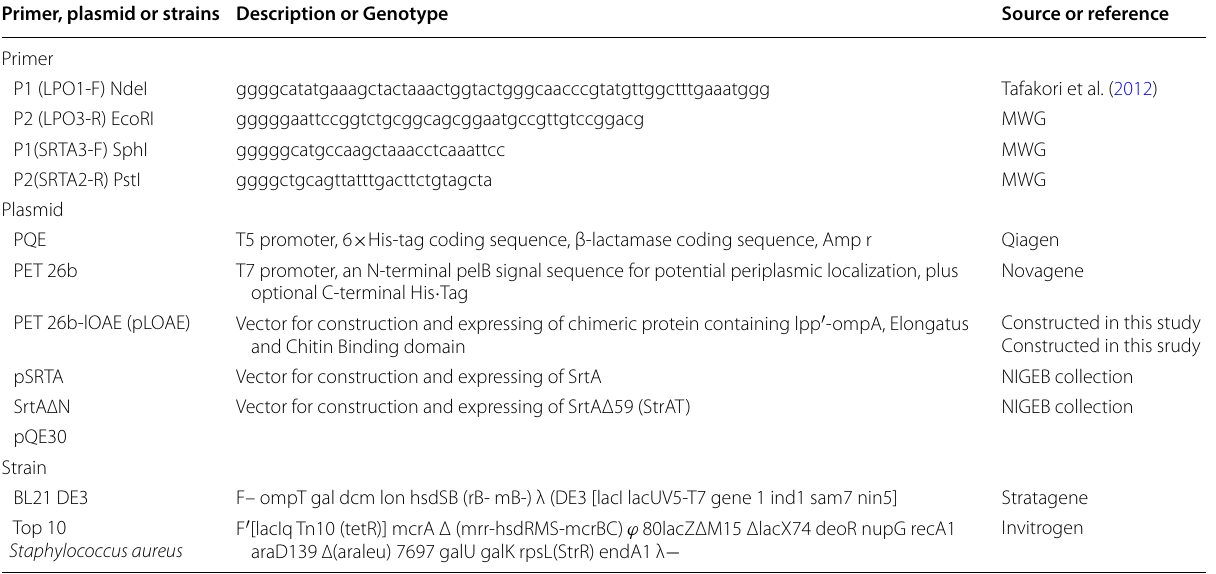
Table 1 Primers, plasmids and strains used in this study Primer, plasmid or strains Description or